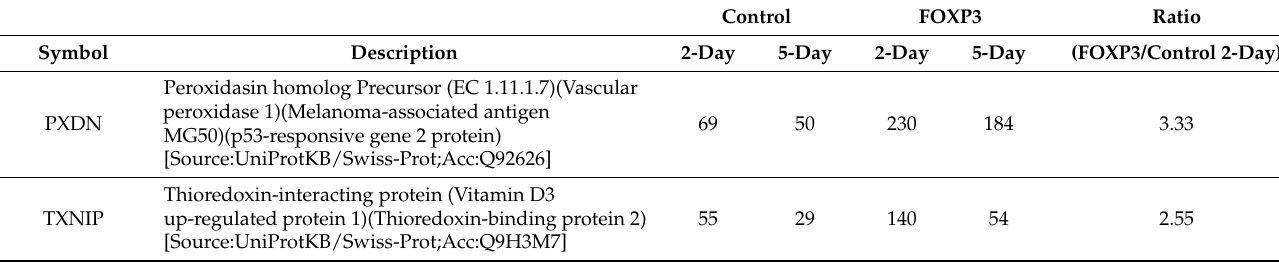
Figure 4. Assessment of the sensitivity of FOXP3 + cells to oxidative stress. The measurement of antioxidant levels and caspase activity in response to H 2 O 2 were compared with those in control cells. Glutathione content in FOXP3 2-day and FOXP3 5-day cells were compared with control cells ( a ). Caspase activity in response in the abovementioned cells exposed to 100 µ M H 2 O 2 for 4 h were measured ( b ). mRNA expression of peroxiredoxins in CD4 + CD25 + CD127 − /low T cells were quantified by real-time PCR ( c ). Table 2. Microarray